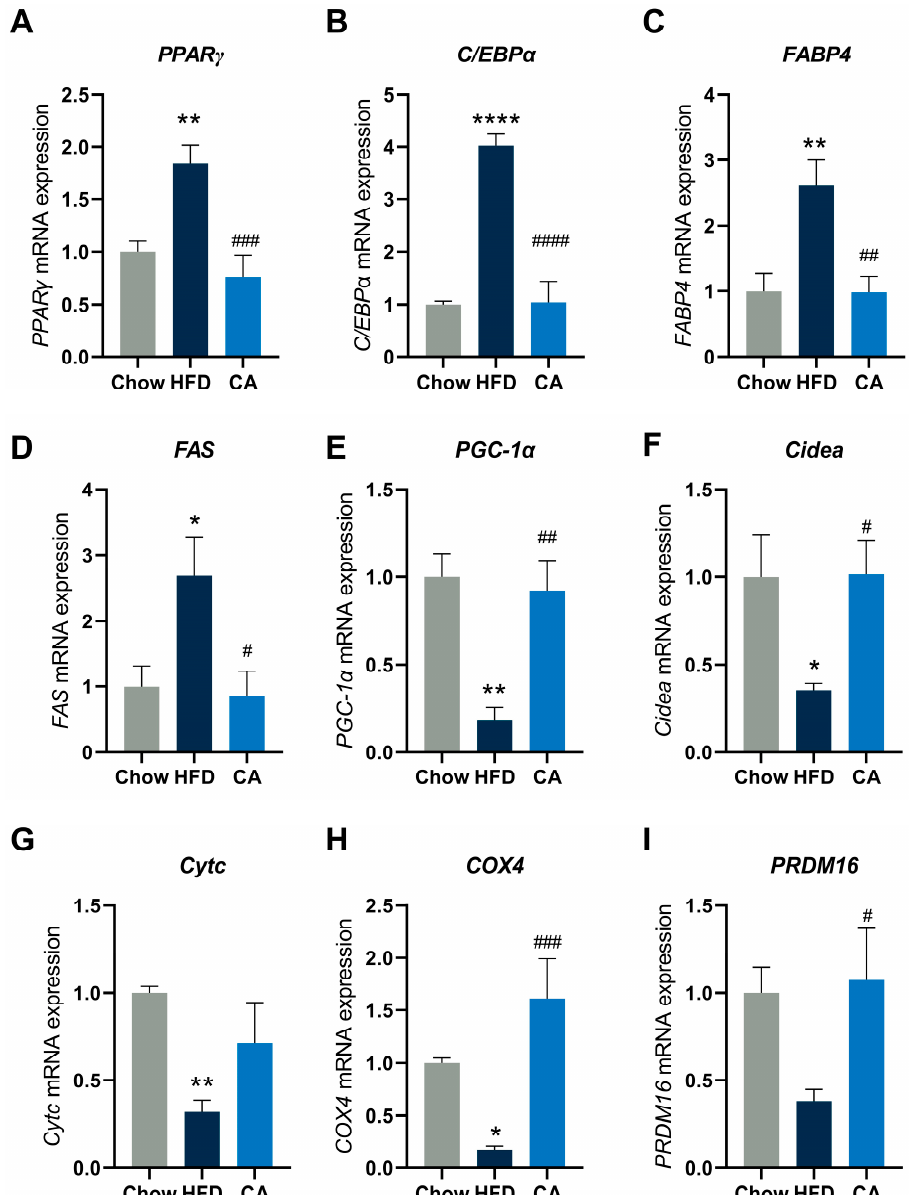
Figure 8. CA alters the expression of metabolic genes in eWAT. Data are expressed as means ± SEM ( n = 6). The expression of ( A ) Peroxisome proliferator-activated receptor gamma ( PPAR γ ), ( B ) CCAAT/enhancer binding-protein α ( C/EBP α ), ( C ) fatty acid-binding protein 4 ( FABP4 ), ( D ) fatty acid synthase ( FAS ), ( E ) peroxisome proliferator-activated receptor gamma coactivator 1-alpha ( PGC-1 α ), ( F ) cell death activator CIDE-A ( Cidea ), ( G ) cytochrome c ( Cytc ), ( H ) cytochrome c oxidase subunit 4 ( COX4 ), and ( I ) PR domain containing 16 ( PRDM16 ) in the epididymal adipose tissues of mice. * p < 0.05 vs. Chow group, ** p < 0.01 vs. Chow group, **** p < 0.0001 vs. Chow group, # p < 0.05 vs. HFD group, ## p < 0.01 vs. HFD group, ### p < 0.001 vs. HFD group, #### p < 0.0001 vs. HFD group.